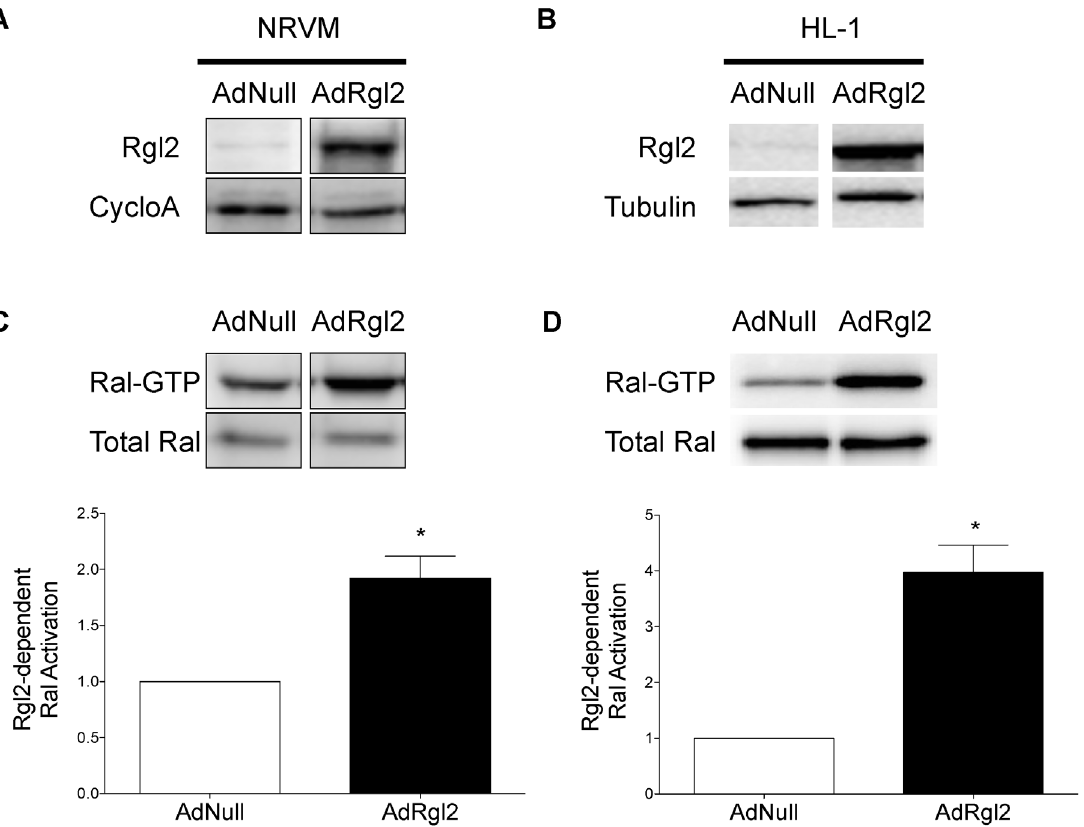
Figure 4. Adenoviral-mediated expression of Rgl2 in cardiomyocytes. NRVMs (A and C) or HL-1 cardiomyocytes (B and D) were infected with 90 ifu/cell of AdNull or AdRgl2. After infection, cell lysates were prepared and analyzed for Rgl2 expression (A and B) via immunoblotting using Rgl2 antibodies, and function (C and D) by assessing Ral activation. Rgl2 expression was normalized to cyclophilin A (cycloA) or tubulin. Ral activation was determined as described in Figure 2 and are presented as the ratio of values obtained in AdRgl2- to AdNull-infected cells. Shown are representative immunoblots of a single experiment and the means 6 SEM of at least 4 separate experiments. * denotes significant difference from AdNull infected